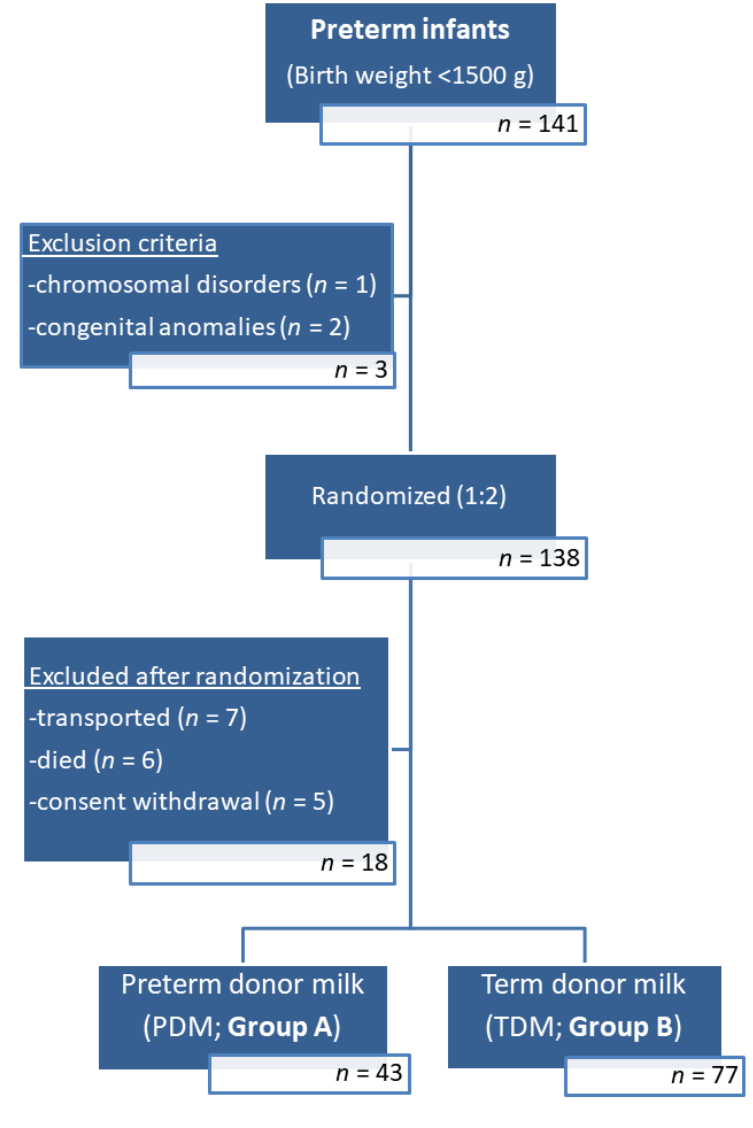
Figure 1. Flow chart of the study population. Maternal age, gestational age, multiple pregnancies, infants’ gender, an thropometric characteristics at birth, SGA status, CRIB II score and length of hospitalization did not differ significantly between Group A and Group B (Table 1). Table 1. Demographic and clinical parameters of the study population. Total Population (N = 120)